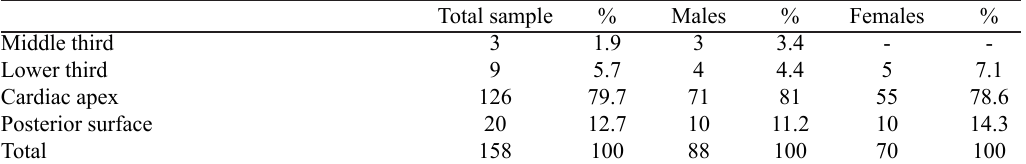
Table 2. Finish of anterior interventricular artery in homonym groove, cardiac apex and posterior surface, by gender discrimination.